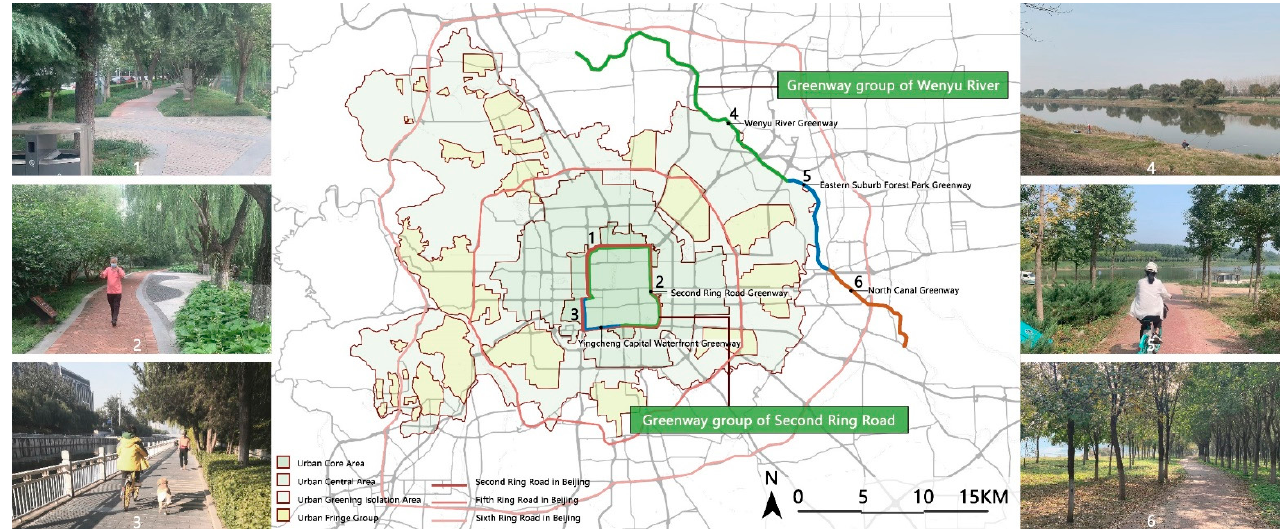
Figure 1. Schematic diagram of the location of the study object.